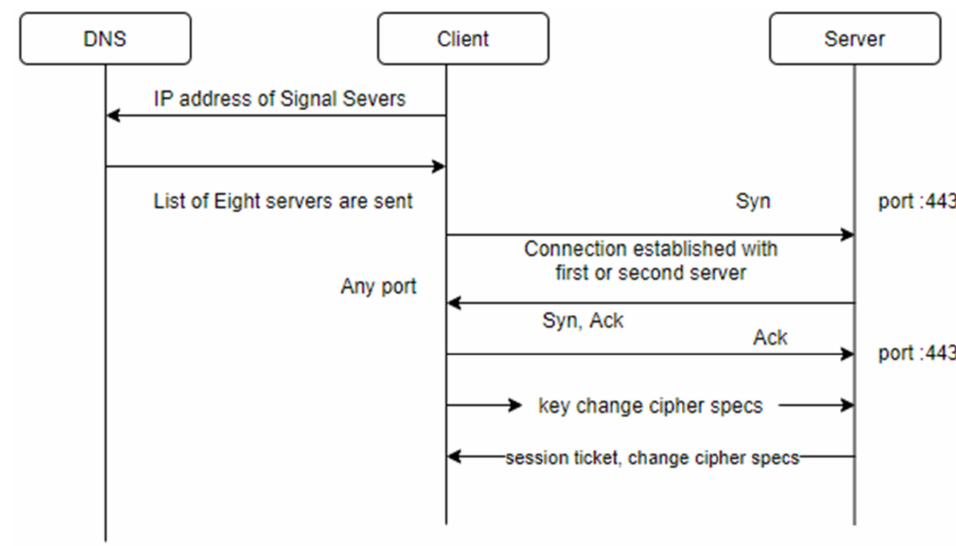
Figure 5. The authentication process of Signal app for connection establishment.